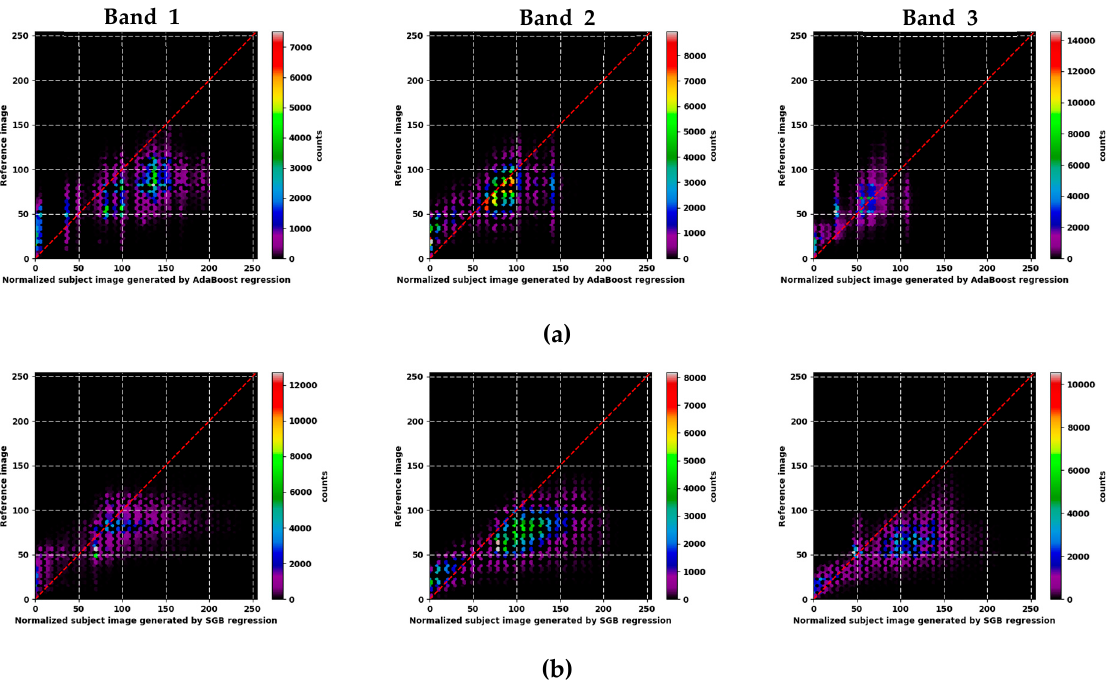
Figure 9. Scattergram of Band 1, Band 2, and Band 3 with reference image: ( a ) AdaBoost regression; and ( b ) SGB regression.